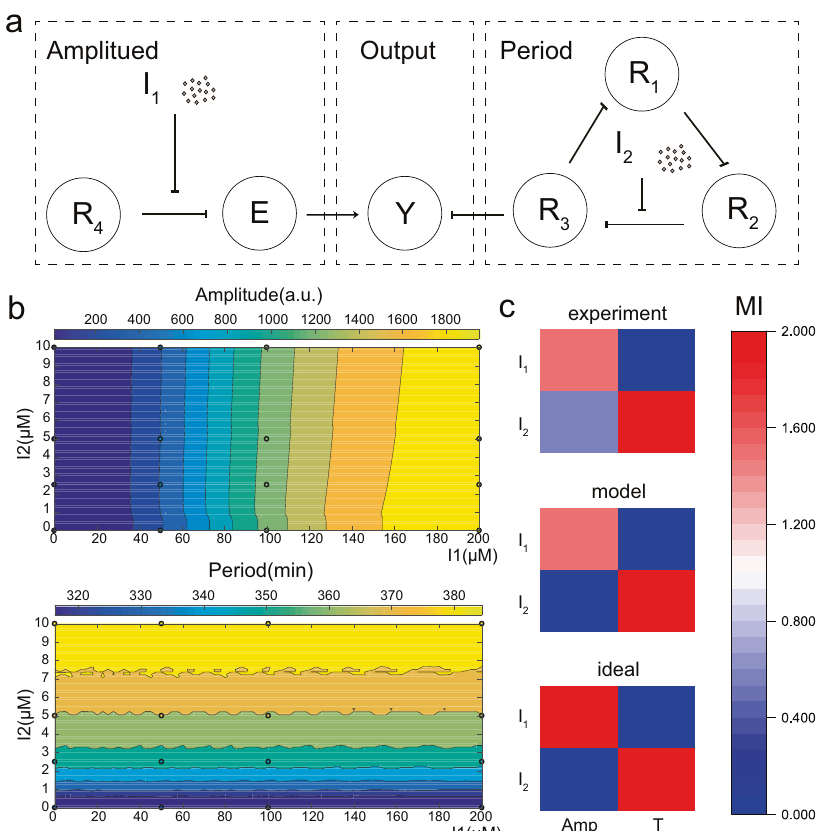
Fig. 5 Quantitative mathematical modeling of the repressilator. a Relation diagram of the quantitative model. The model has three parts, the regulation of period, amplitude, and output. b Simulation of the quantitative model. The x -axis represents the concentration of salicylate ( I 1 ), the y -axis represents the concentration of IPTG ( I 2 ). Different values of amplitude and period are represented by different colors. The results of experiments are shown in the form of hollow dots with corresponding colors. c MI metrics between the inputs, amplitude, and period. MI (Amp, T ), MI ( I 2 , Amp), and MI ( I 1 , T ) are close to zero, meaning that the amplitude and period are not coupled and the regulation of the two inputs are